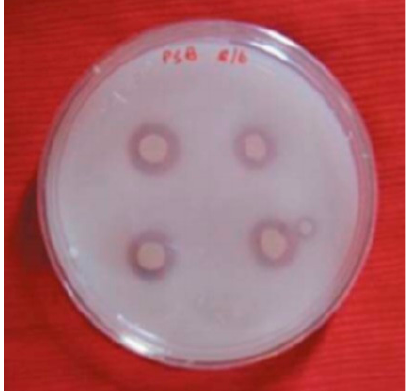
Figure 7. Agar plate overlaid with hydrocarbons. Positive emulsified halo. Source: [85].